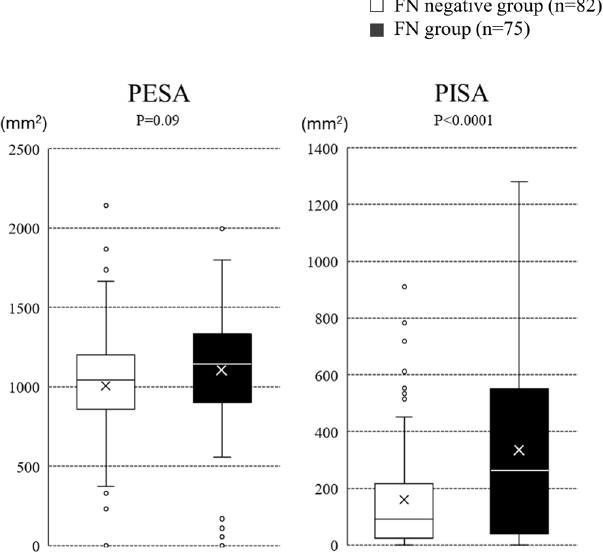
Figure 2. PESA and PISA in FN and the FN negative groups. PESA was not significantly different between the groups, whereas PISA was significantly higher in the FN group (P < 0.0001) (Welch’s t-test).